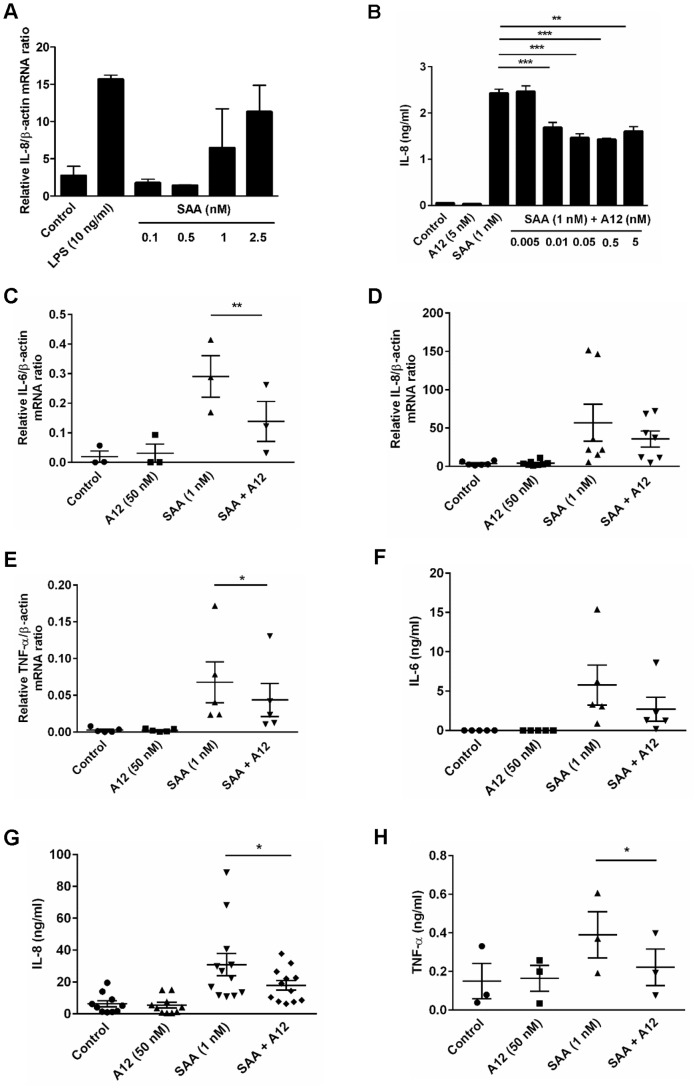
S100A12 reduced SAA-induced cytokine responses.(A) Dose-dependent induction of IL-8 mRNA by SAA. PBMC treated with LPS (10 ng/ml) or SAA (0.1, 0.5, 1, 2.5 nM) for 4 h, and IL-8 mRNA quantitated by real-time RT-PCR; β-actin mRNA served as endogenous control. Data represent means (relative to β-actin mRNA) ± SEM of duplicate measurements from two separate experiments. (B) THP-1 cells treated with SAA (1 nM), S100A12 (5 nM) and SAA (1 nM)+S100A12 (0.005, 0.01, 0.05, 0.5, 5 nM) for 15 h and IL-8 levels in supernates quantitated by ELISA. Data represent means ± SEM of duplicate measurements from three separate experiments. **p<0.01 and ***p<0.005 compared to SAA alone (analyzed by one-way ANOVA with Bonferroni’s correction for multiple comparison tests). (C–H) PBMC treated with SAA (1 nM), S100A12 (50 nM) or SAA ± S100A12 for 4 h (mRNA) or 15 h (protein). mRNA levels of (C) IL-6, (D) IL-8, and (E) TNF-α quantitated. Data represent ratios of cytokine mRNA levels relative to β-actin mRNA; means ± SEM of PBMC preparations from at least three independent donors, *p<0.05 and **p<0.01 compared to SAA alone (analyzed by paired t-tests). Levels of (F) IL-6, (G) IL-8 and (H) TNF-α from supernates of PBMC harvested 15 h post-stimulation quantitated by ELISA. Data represent means ± SEM of duplicate assays from at least three independent healthy blood donors, *p<0.05 compared to SAA alone (analyzed by paired t-tests).